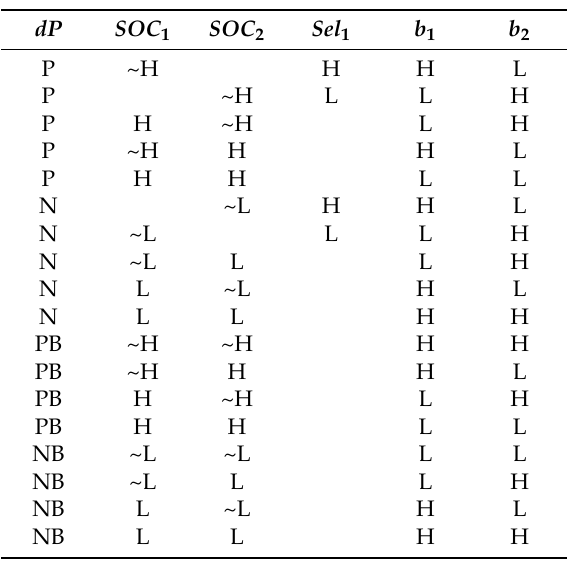
Table 2. Rule base of fuzzy logic controller.